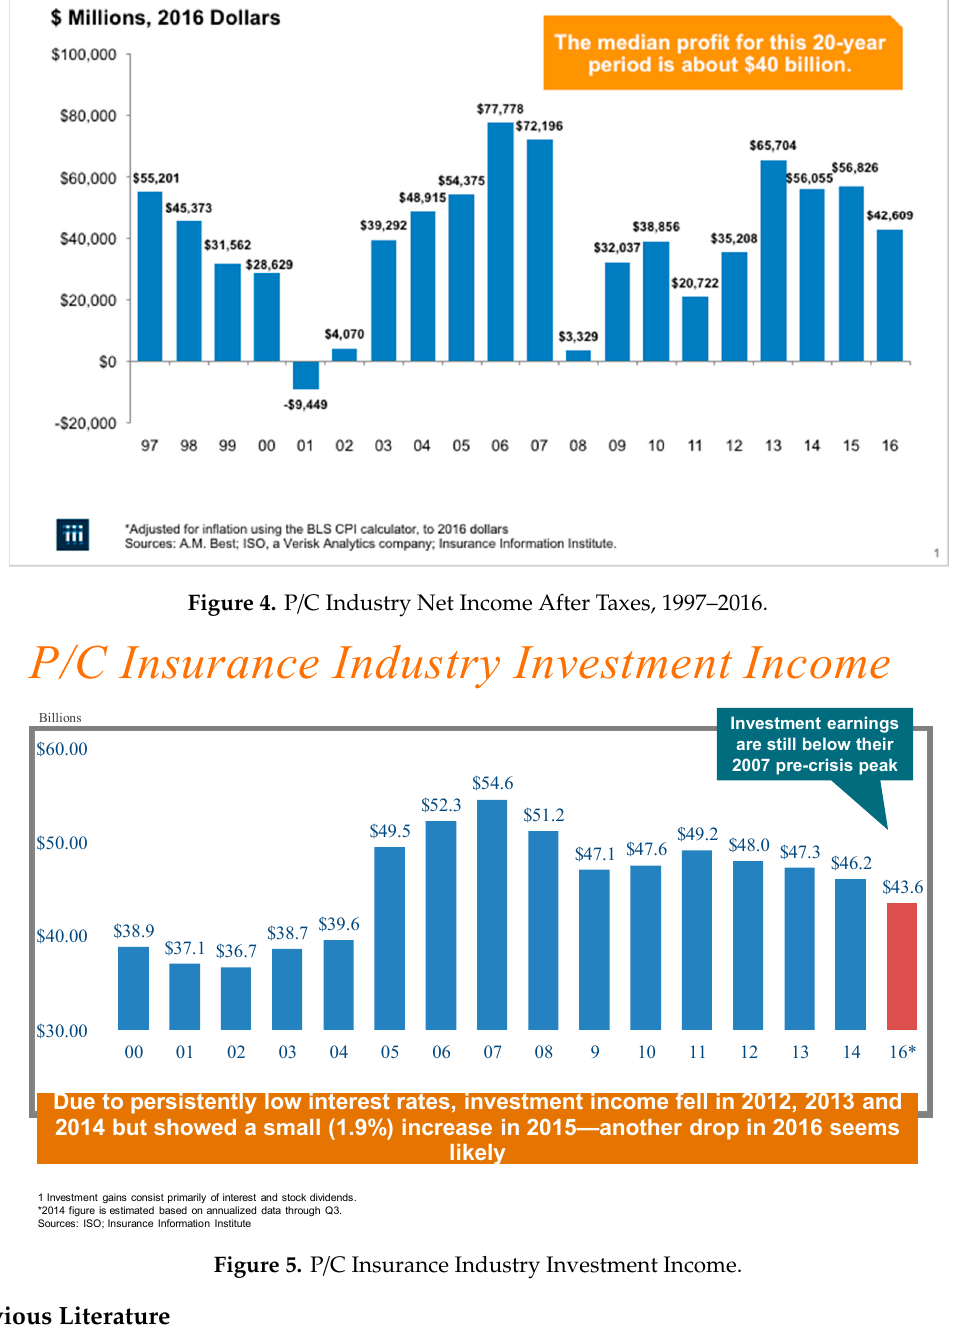
Figure 5. P/C Insurance Industry Investment Income.